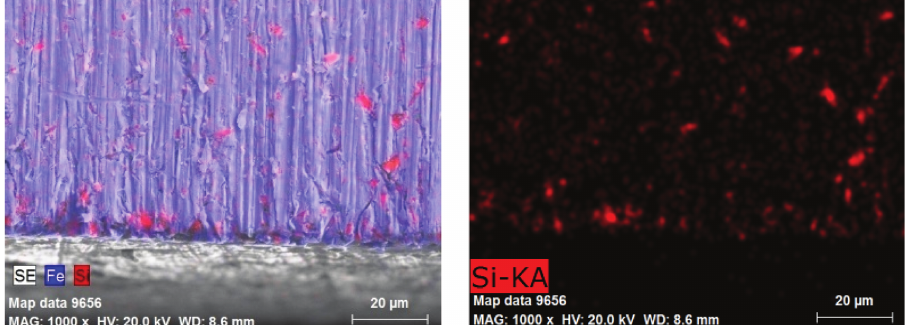
Figure 9: EDS mapping result of the 1.2% Si silicon steel matrix.